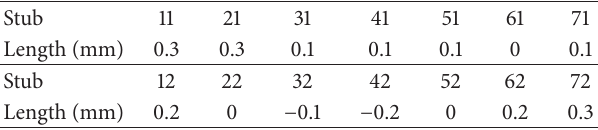
Table 3: Dimensions of the improved